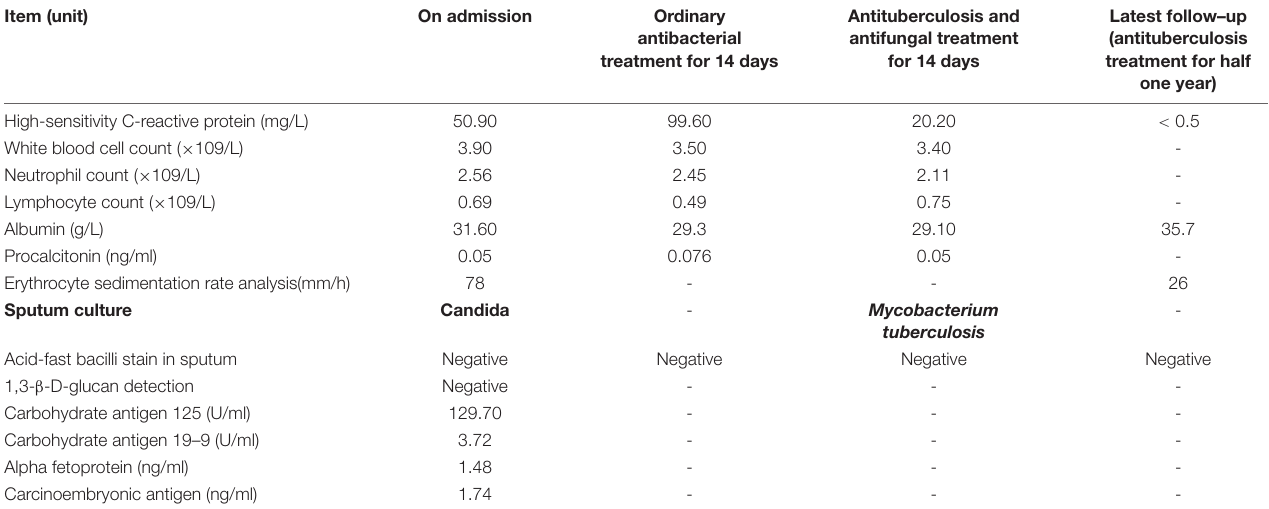
TABLE 1 | Laboratory examination results during the diagnosis and treatment of patients. Item (unit)